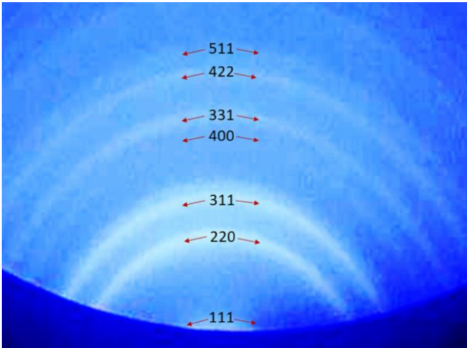
Figure 5. Reflection high-energy electron di ff raction (RHEED) pattern measured on sample in annealed temperature T = 580 ◦ C. The Bragg plane of the Ge lattice, corresponding to each Debye ring, is indicated.